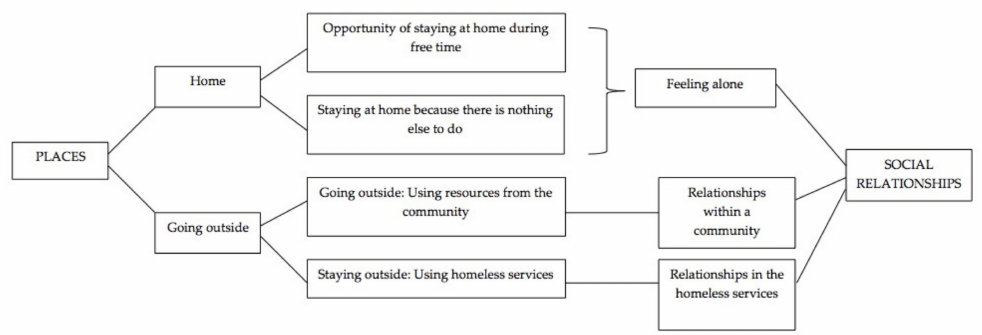
Figure 2. Generated themes concerning social relationships and